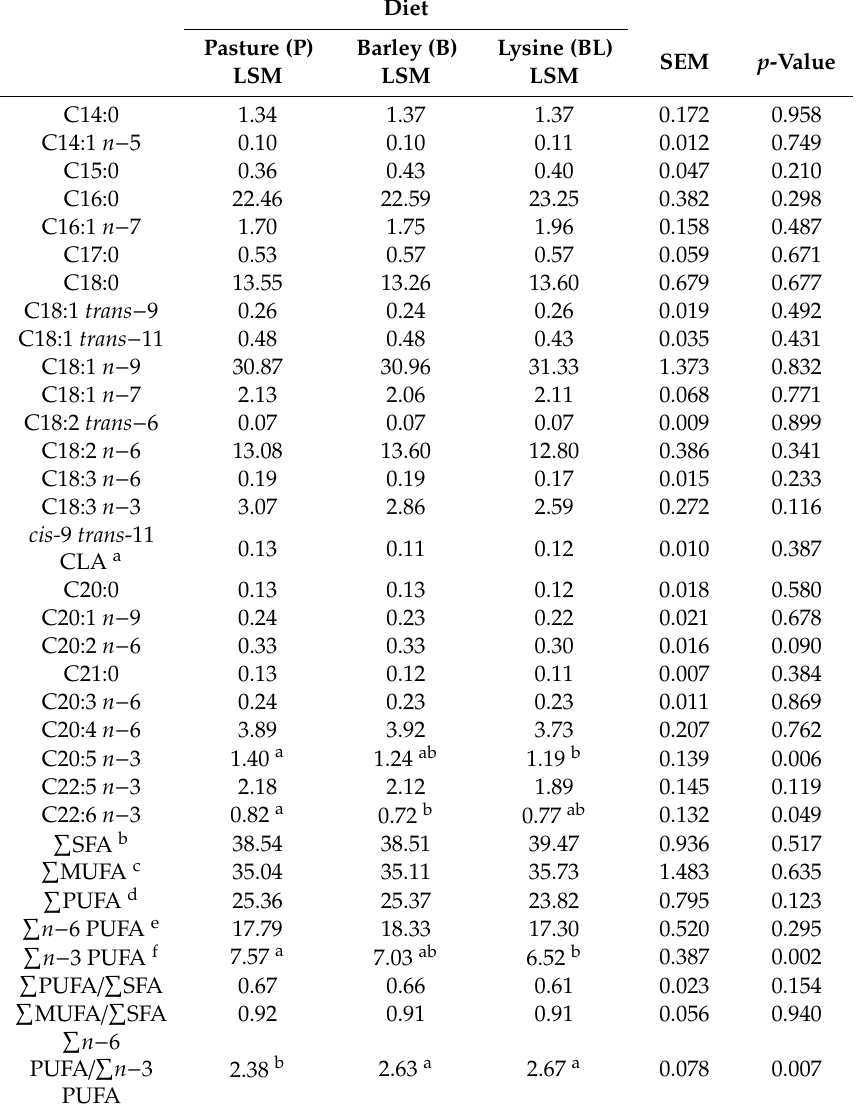
Table 5. Fatty acid proportions, sums and ratios (g / 100 g of total fatty acid determined) of fallow deer receiving di ff erent